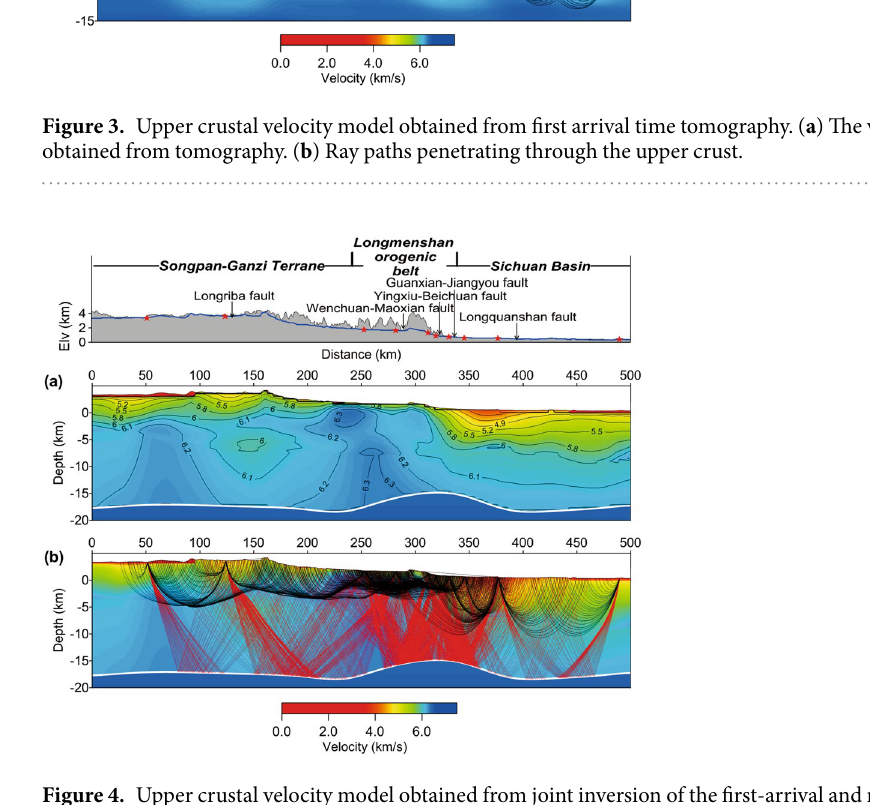
Figure 4. Upper crustal velocity model obtained from joint inversion of the first-arrival and reflection times. ( a ) Velocity image of the upper crust with an intra-crustal interface, at the average depth of 17 km. ( b ) Ray paths of the first arrivals and the reflection